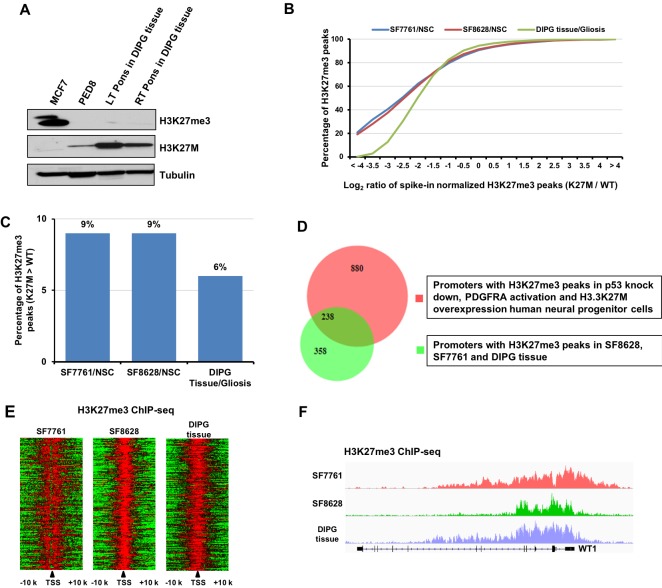
A small fraction of H3K27me3 peaks shows an equal or higher level of H3K27me3 in DIPG tumor cells than the corresponding reference cells.(A) The level of H3K27me3 is reduced dramatically in H3.3K27M cell line PED8 and in two distinct regions of a DIPG primary tissue. Primary tissues from a patient autopsy sample were separated into left and right Pons. MCF7 cells (the breast cancer cells) were used as a negative control. H3K27M proteins were detected by Western blot using antibodies against H3K27M. (B) Compared to the reference human NSC or H3 wild type control gliosis tissue, a fraction of H3K27me3 peaks exhibits an increased level of H3K27me3 while most others are reduced in DIPG cells and primary DIPG tissues. H3K27me3 ChIP-seq was performed in cell lines (SF7761, SF8628, and NSC) and tissues (gliosis and DIPG tissue) with spiked-in chromatin from Drosophila or sf9 cells. H3K27me3 peaks were identified and cumulative distribution analysis of the Log2 ratio of the H3K27me3 levels between DIPG cells and the reference NSC or between the DIPG tissue and gliosis tissue was shown (X-axis). (C) The percentage of H3K27me3 peaks that had higher H3K27me3 levels in H3.3K27M DIPG cells or tissue than the corresponding reference cells was shown. (D) Venn diagram illustration of genes with H3K27me3 peaks obtained through the transformation of human NPCs by p53 knockdown, expression of PDGFRA mutation and H3.3K27M as well as those identified from SF8628, SF7761 and DIPG tissues. The H3K27me3 ChIP-seq dataset in NPCs was from Funato et al. (Funato et al., 2014). The gene promoters with H3K27me3 peaks in all of SF8628, SF7761 and DIPG tissues were used for comparison. (E) Heatmaps represent the signal of H3K27me3 from 10 Kb up- to 10 Kb down-stream of TSS of 676 genes identified in Figure 3B. (F) A genome browser track example for the H3K27me3 occupancy at Wilms Tumor 1 (WT1) locus in the two DIPG line and tissue.